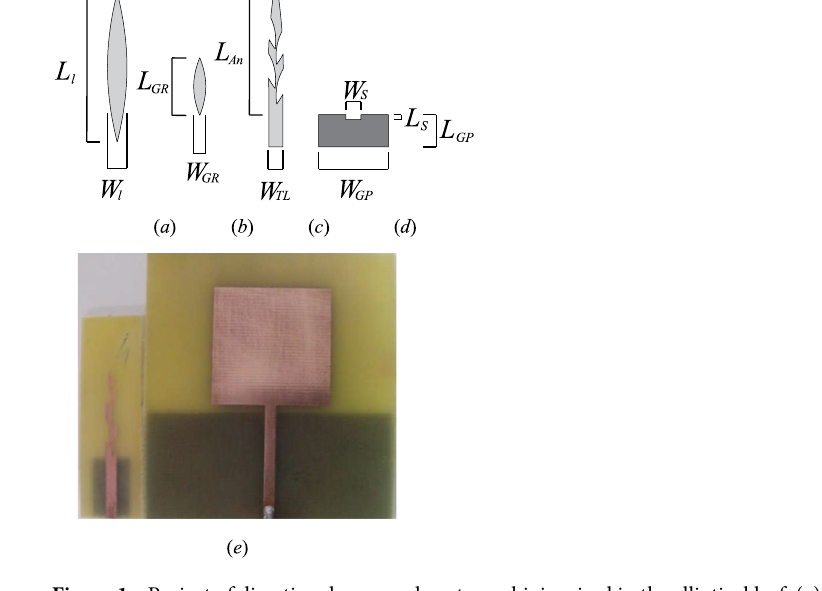
Figure 1. Project of directional monopole antenna bioinspired in the elliptical leaf: ( a ) Dimensions of the leaf performed in MATLAB 2015(b); ( b ) Dimensions of the leaf calculated by golden ratio performed in MATLAB 2015(b); ( c ) simulated antenna with the cuts performed in Ansys 2016; ( d ) ground plane of the antenna.